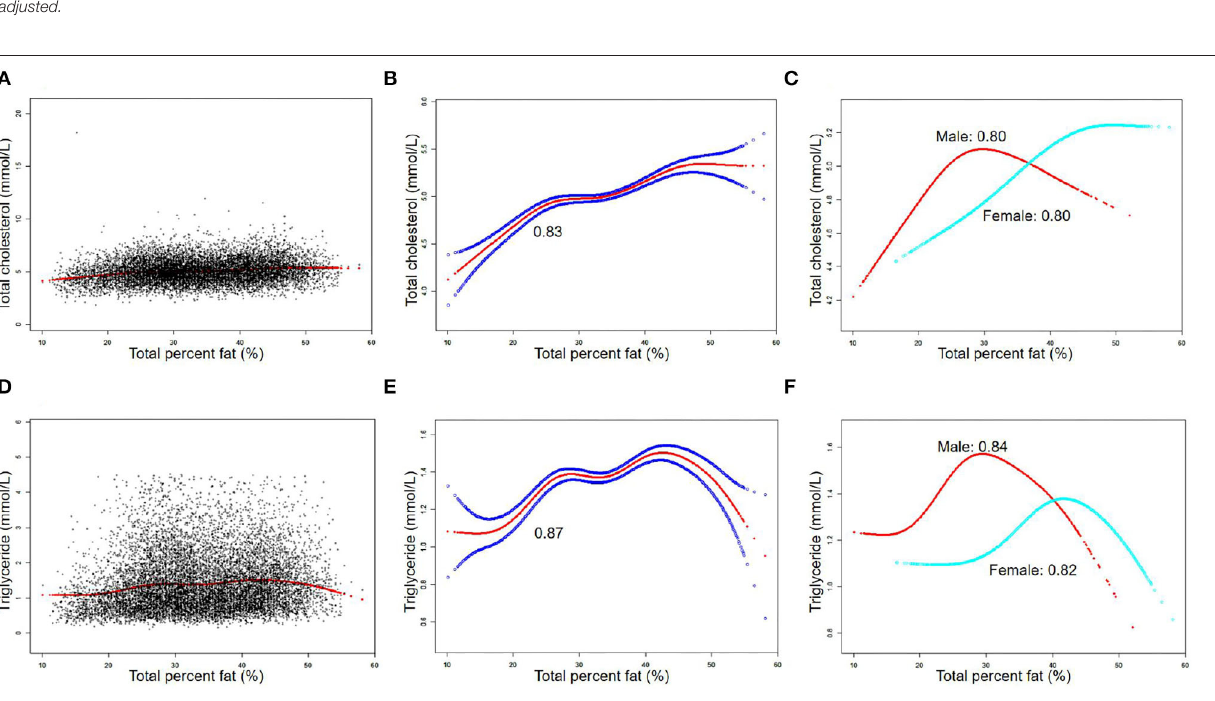
FIGURE 1 | The association between total percent fat (%) and total cholesterol, triglyceride (mmol/L). (A,D) Each black point represents a sample. (B,E) Solid red line represents the smooth curve fit between variables. Blue bands represent the 95% of confidence interval (CI) from the fit. (C,F) Stratified by sex. The correlation coefficients of (B,C,E,F) were described in the corresponding figures. Age, sex, race, BMI, hypertension, diabetes, smoking status, and vigorous work activity were adjusted [ (C) and (F) were not adjusted by